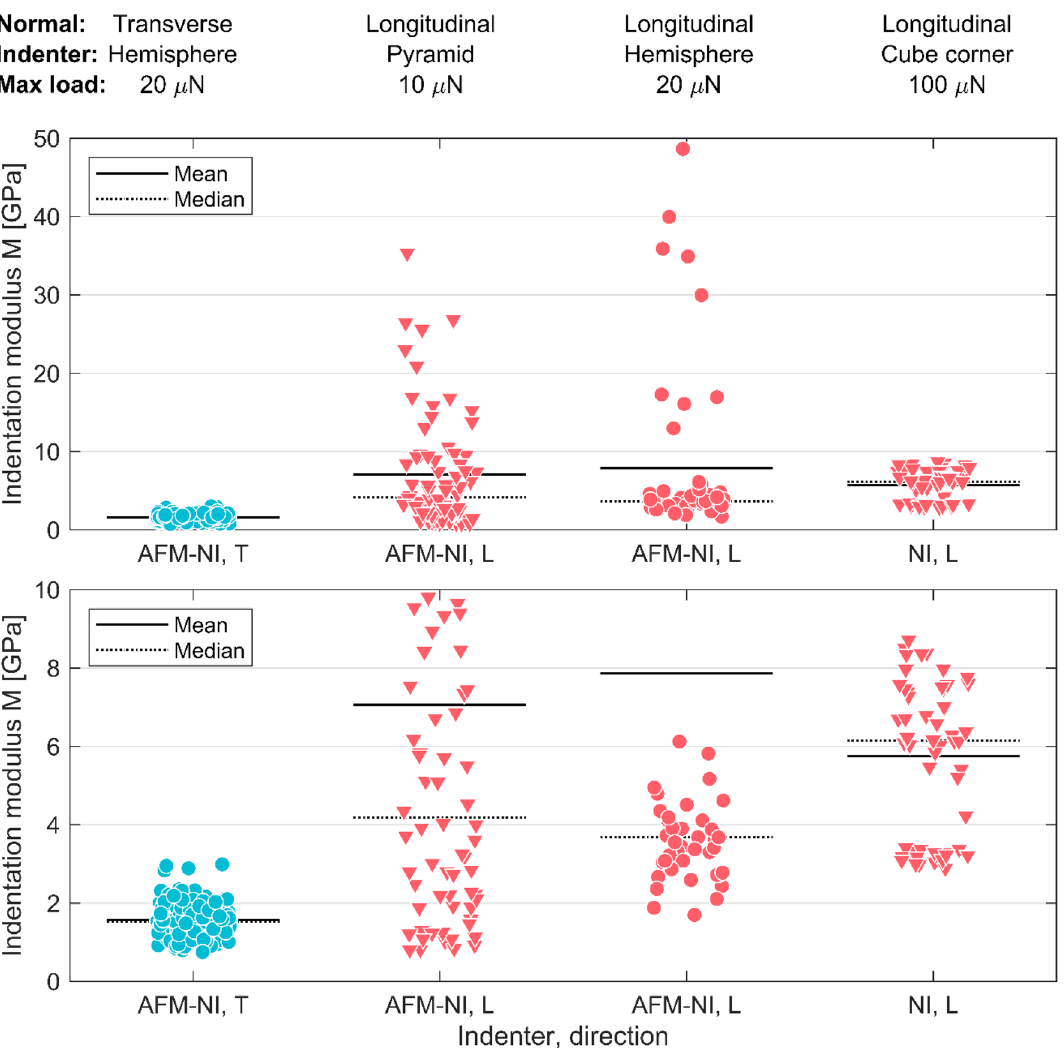
Figure 5. Indentation moduli obtained by AFM-NI and NI in the transverse (T) and longitudinal (L) direction with pyramidal/cube corner ( ▼ ) and hemispherical ( ● ) indenters. The lower subplot is a zoomed in version of the upper